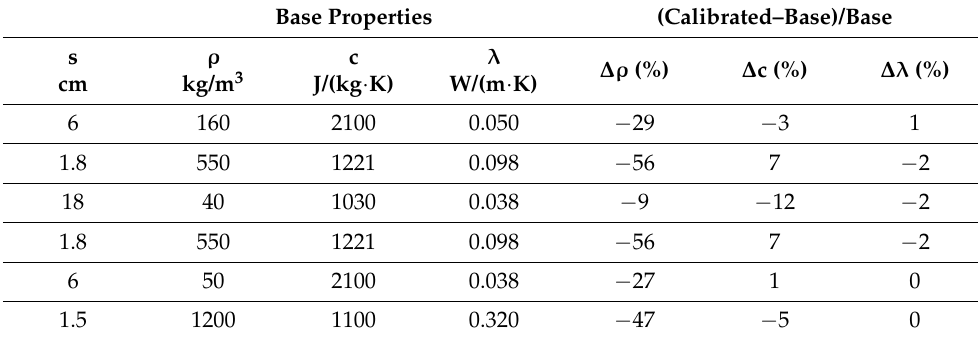
Table 7. UniTN-TRNSYS calibration of the external wall: base and calibrated properties.